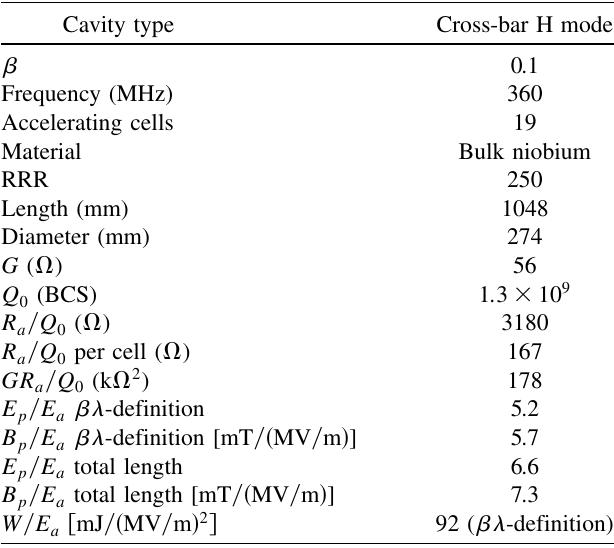
FIG. 10. (Color) Electric and magnetic peak field as a function of the stem width b at constant a and L (cid:1) 42 : 6 mm . The peak fields are based on the (cid:1)(cid:2) definition of the gradient. TABLE I. Parameters of the superconducting CH prototype